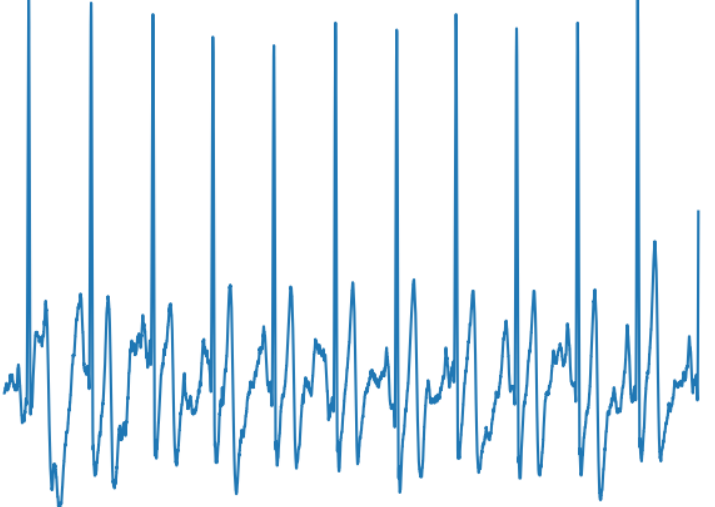
Figure 15. Pre-analysis of the signal was: Normal Sinus Rhythm. Waiting time for classification: 19 ms. (No magnitudes are indicated to avoid noise to the neural